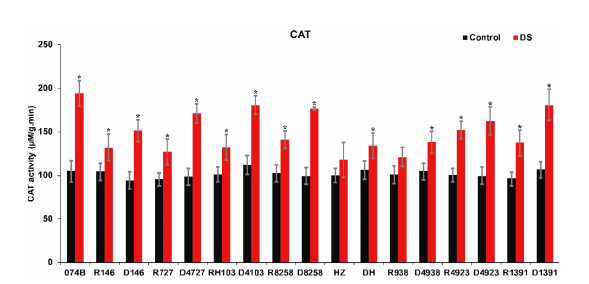
FIGURE 5 POD activity of restorer lines and hybrid progeny after drought treatment. POD represents peroxidase; DS represents drought stress treatment. Error bars denote standard deviations ( n = 3); “ * ” stands for signi fi cance between drought stress and control condition in the same cultivar (p ≤ 0.05).